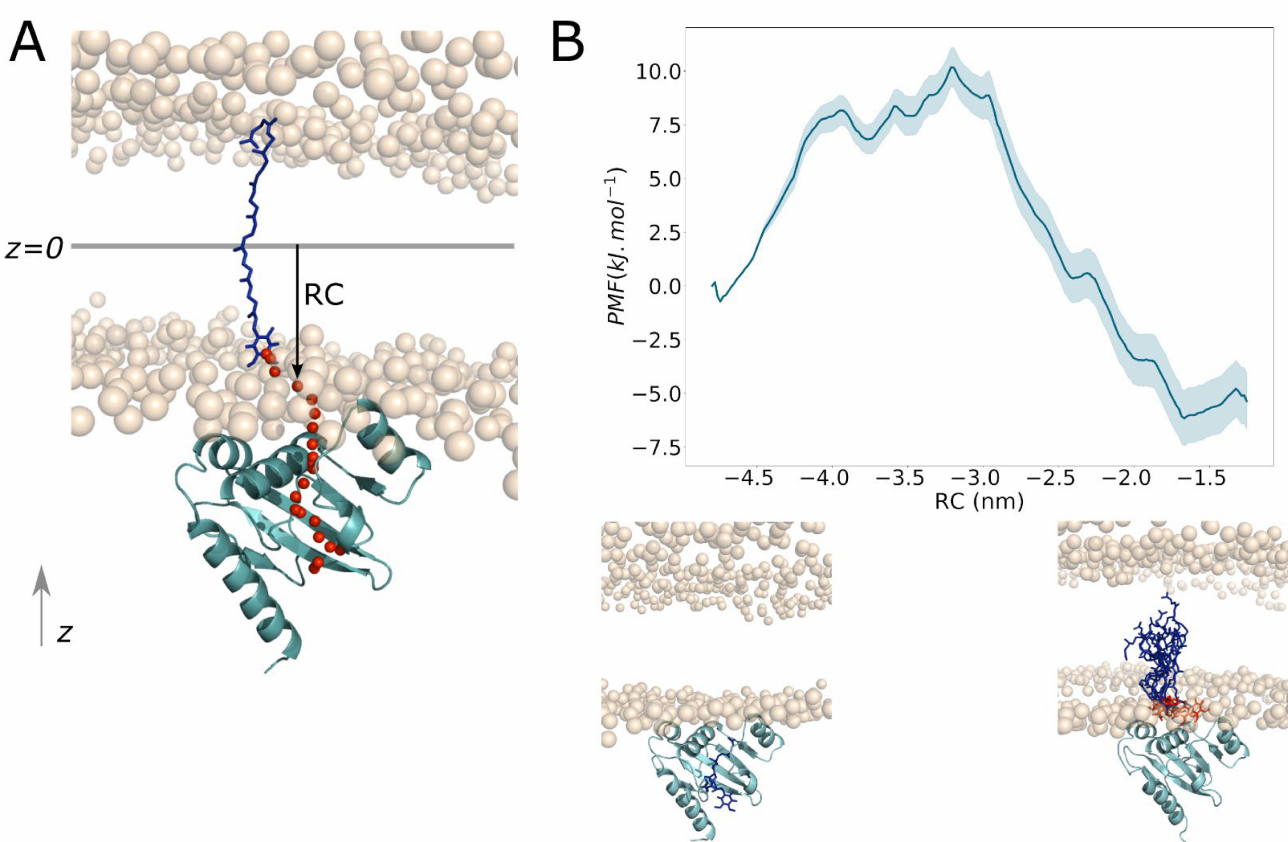
Figure 12. Free energy calculations of UQ 8 release. ( A ) A schematic representation of the release pathway is displayed. The SCP2 domain is shown in cyan cartoon whereas the reference points used as reaction coordinates RC are shown in red spheres (mass centres of the quinone head). The red spheres are uniformly spaced of 2 Å along the z-axis. UQ 8 is represented as blue sticks at the end of the pulling. The orange spheres correspond to polar heads of the membrane. ( B ) PMF of the UQ 8 release along the reaction coordinate RC shown by a black arrow as an example in ( A ). Two snapshots illustrate the UQ 8 position according to the two main